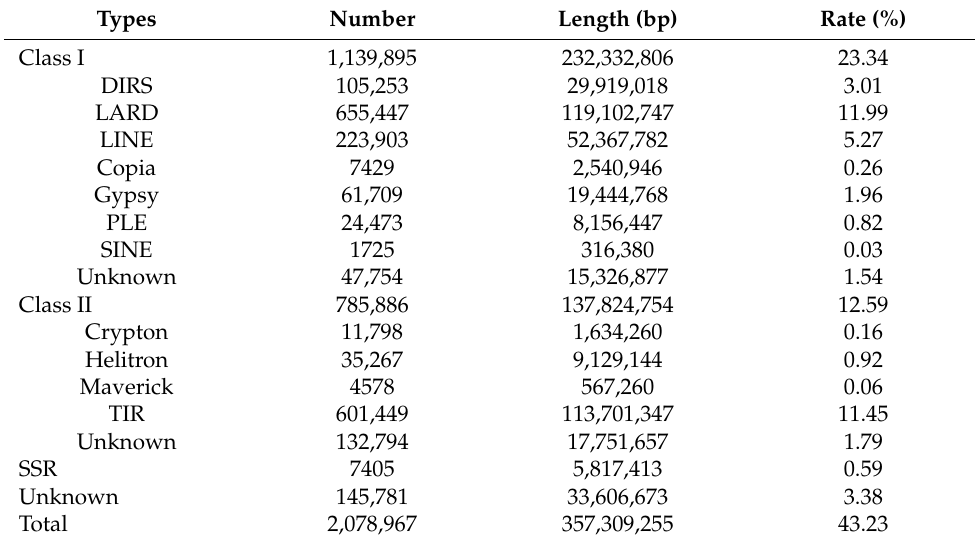
Table 1. Repetitive sequences in the O. bidens genome.